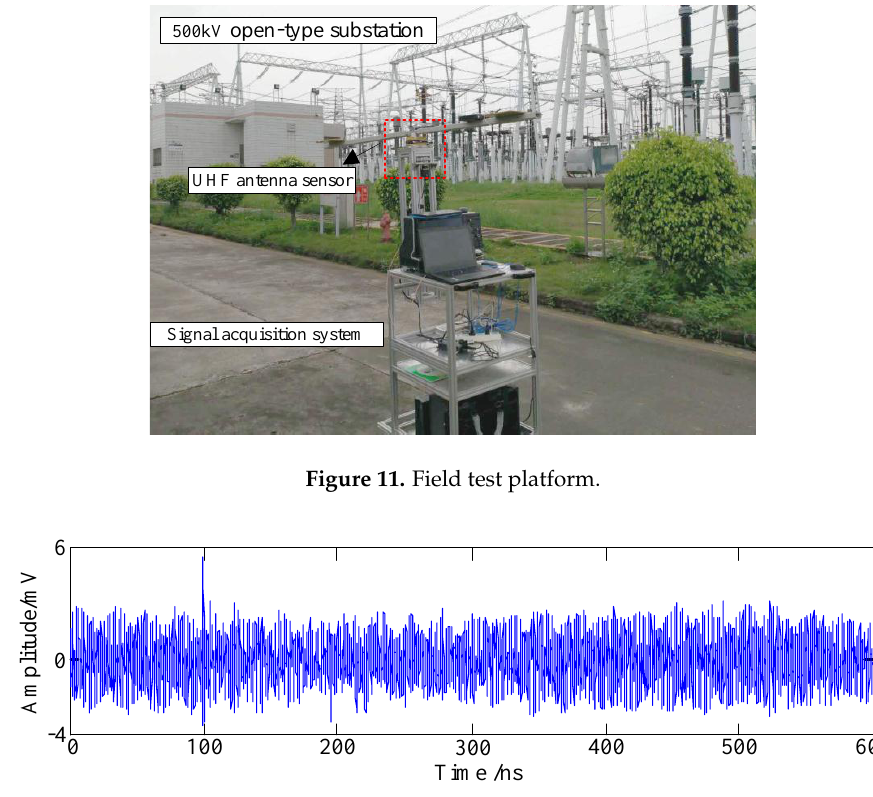
Figure 12. The detected PD UHF signal in the field test.